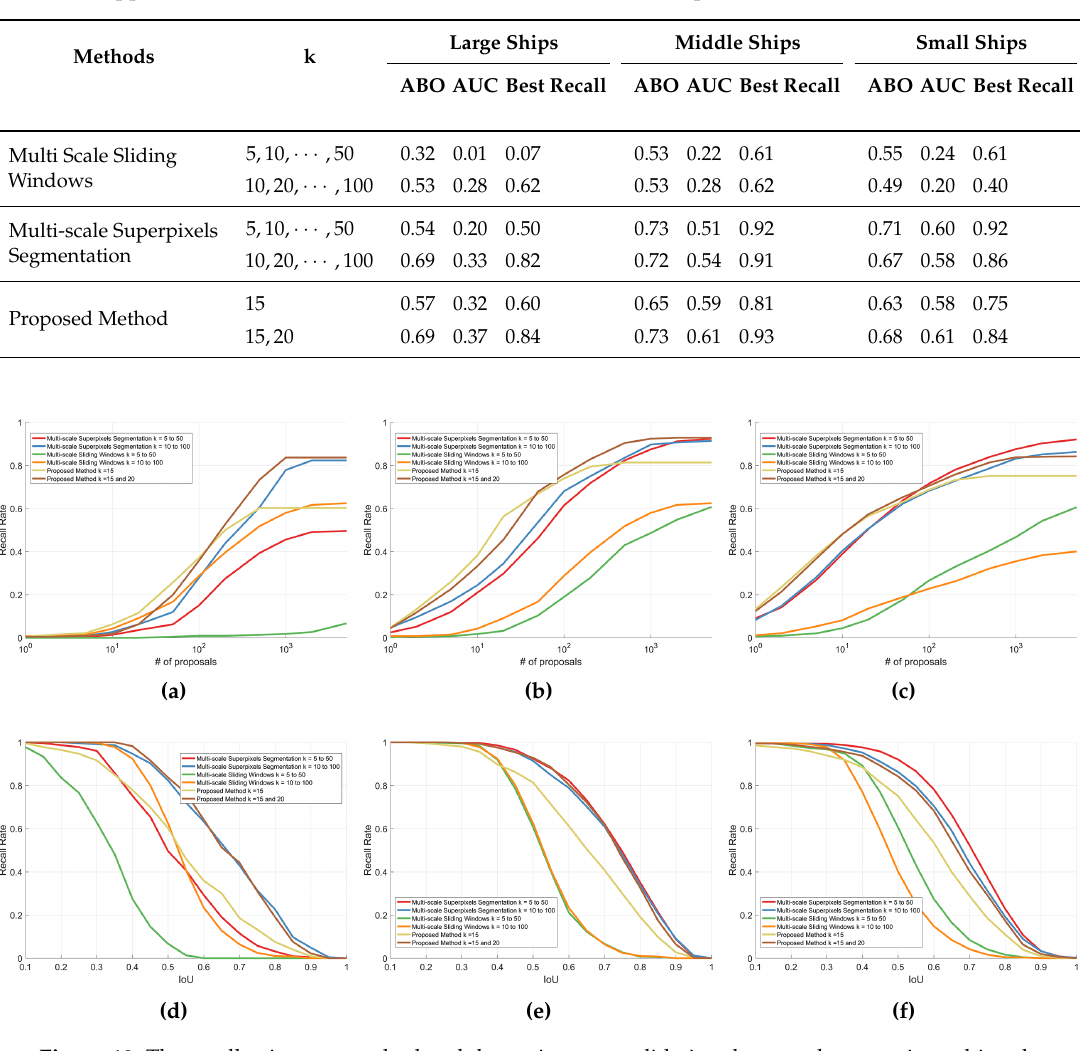
Figure 10. The recall using our method and the variants on validation datasets that contain multi-scale ships. ( a – c ) the curves measuring the recall versus numbers of ship proposals on validation datasets that contain large, middle and small scale ships; ( d – f ) the curves measuring the recall versus IoU on validation datasets that contain large, middle and small scale